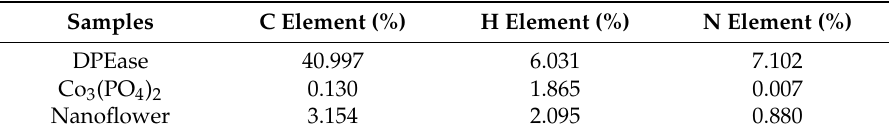
Table 1. Element analysis of nanoflower and its raw materials.